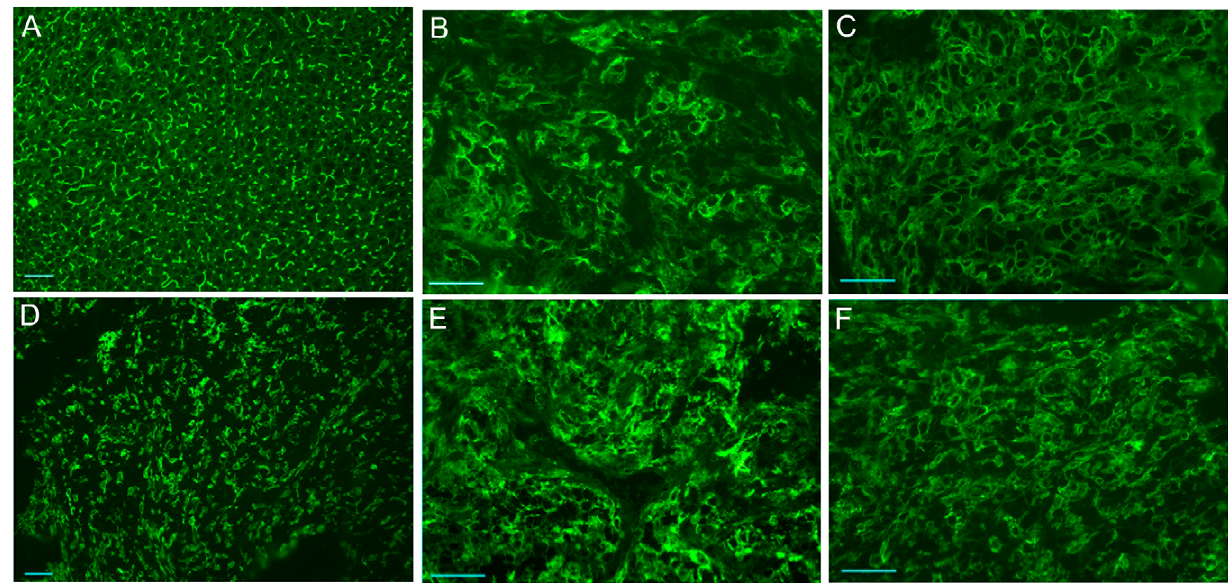
Figure 9. Expression of WT and Mutant CEACAM1-4S on Tumor Nodules. Frozen sections of normal liver or 253T-NT transfectants were stained by indirect immunofluorescence with MAbs 9.2 and 5.4, monoclonal antibodies recognizing the N-terminal Ig domain of CEACAM1-4S. ( A ) Normal rat liver with MAb 5.4; ( B ) 253T-NT expressing wild type CEACAM1-4S; ( C–F ) tumors of 253-NT cells expressing the following mutants: ( C ) G424L with MAb 9.2; ( D ) G424L and G432L with MAb 5.4; ( E ) Y448V with MAb 5.4; ( F ) Y445V and Y448V with MAb 9.2.